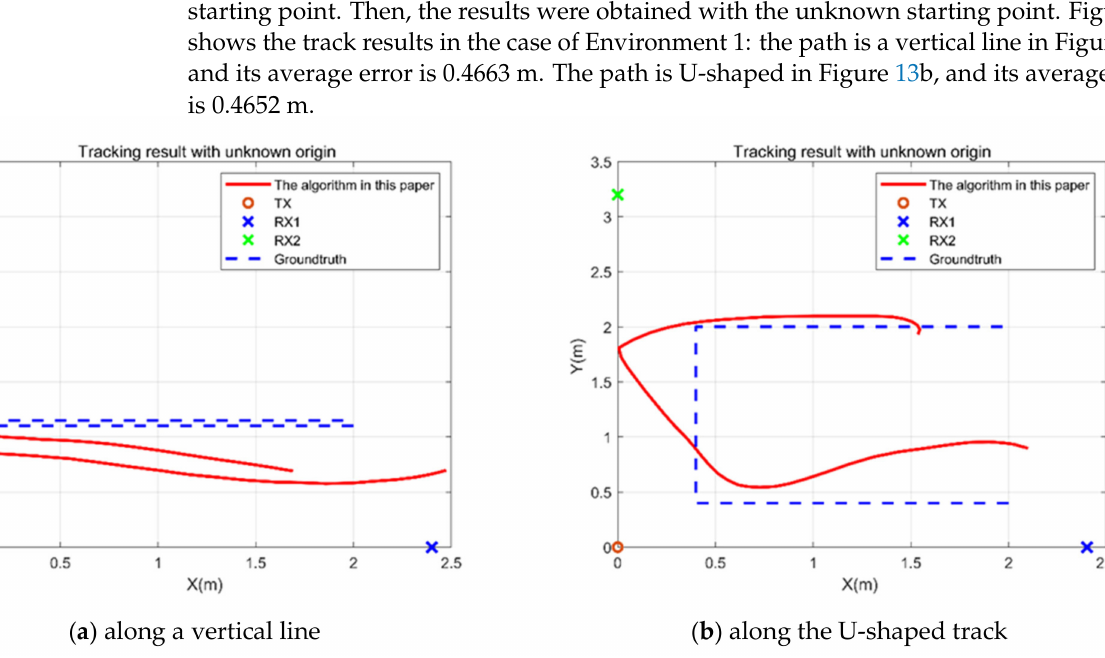
Figure 13. The trajectory prediction of a person walking in Environment